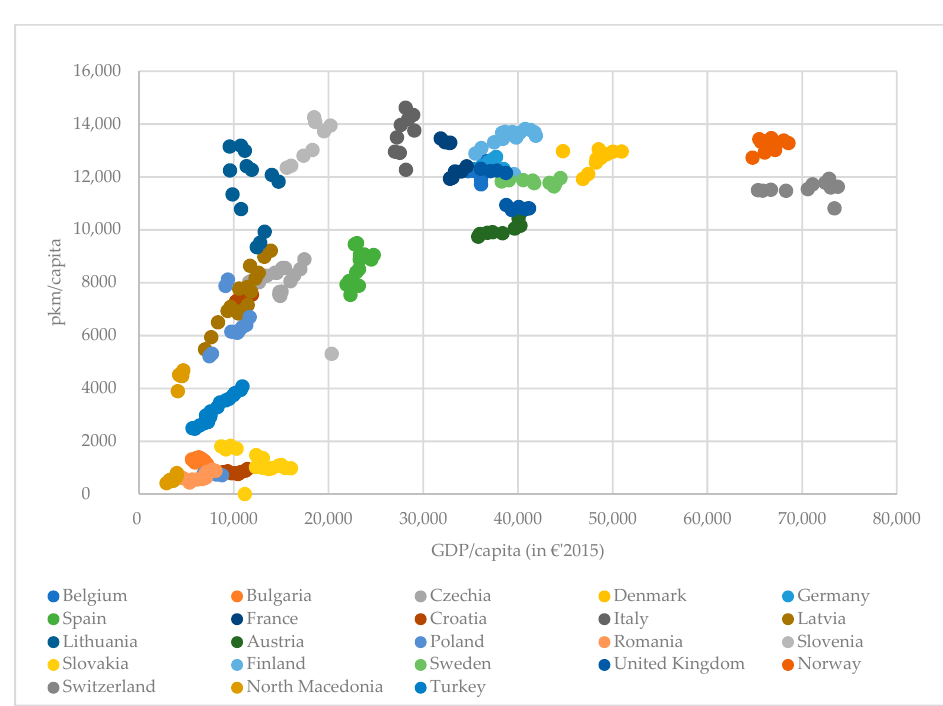
Figure 2. Road transport mobility and gross domestic product in 23 countries, 2002–2018 [34–36]. Modeled vehicle technologies output short or long-distance passenger transporta- tion, or both, depending on vehicle type. For example, personal cars can be used for short and long-distance passenger transportation, so representing technology has two operat- ing modes, one for short and one for long-distance travel. The principal diagram of mod- eling a car in the energy planning model is given in Figure 3. However, used quantities differ between the modes. Internal combustion engine (ICE) cars have a better fuel econ- omy when driving between cities than when driving within a city because of less braking and accelerating cycles, less time stopped at traffic lights and higher efficiency at intercity travel speeds. Besides, due to higher speeds, it takes less time to drive the same distance.